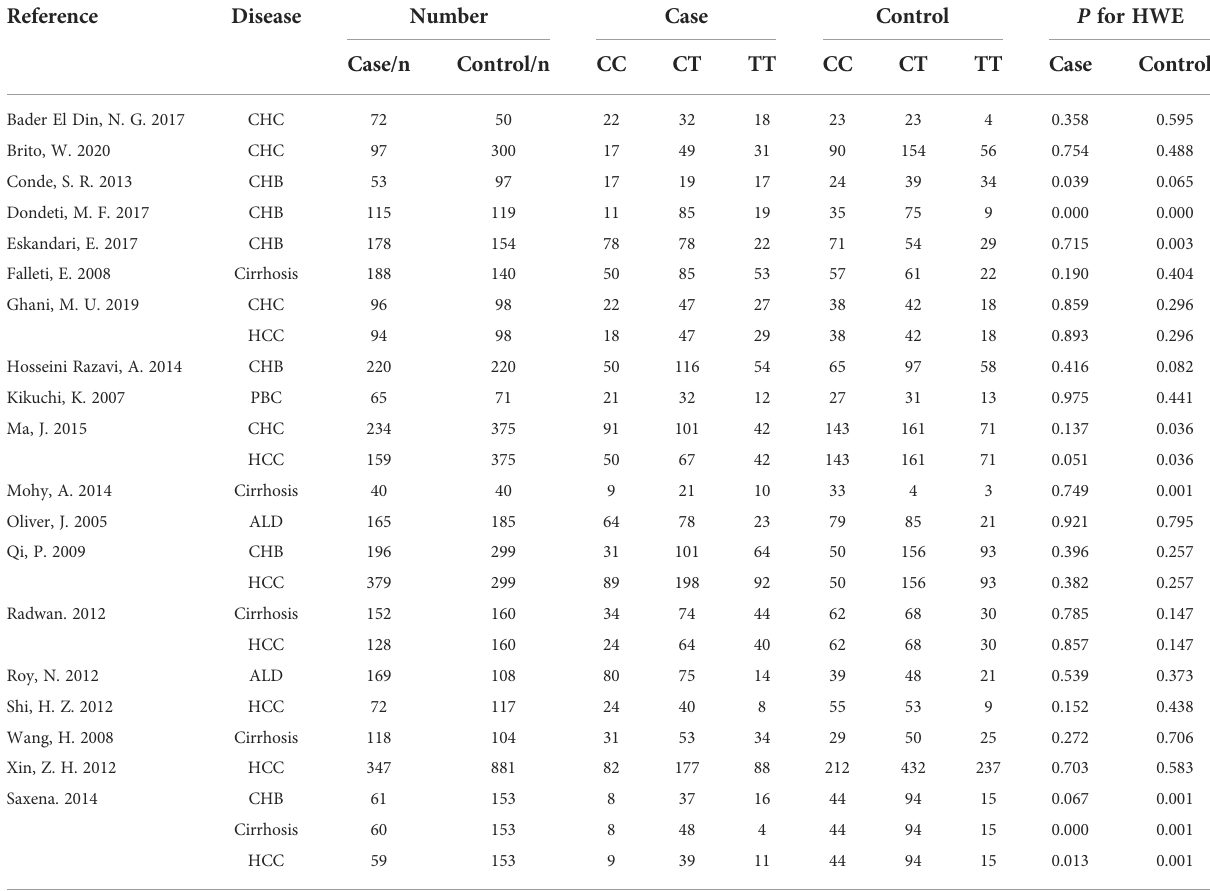
TABLE 2 The genotype and allele frequencies of TGF- b 1 -509C/T distribution of included studies.